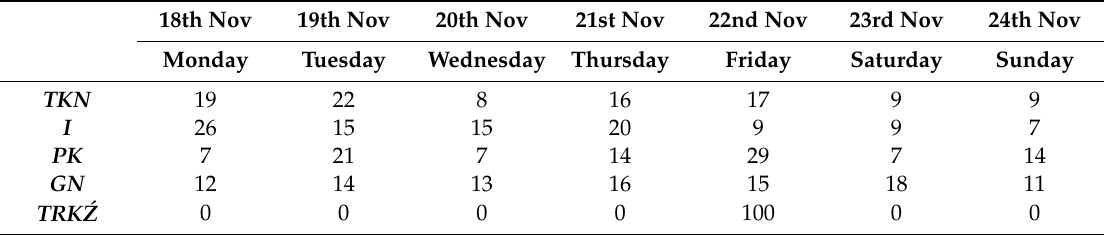
Table 4. Share of the number of posts on FB on subsequent days of the week (%).